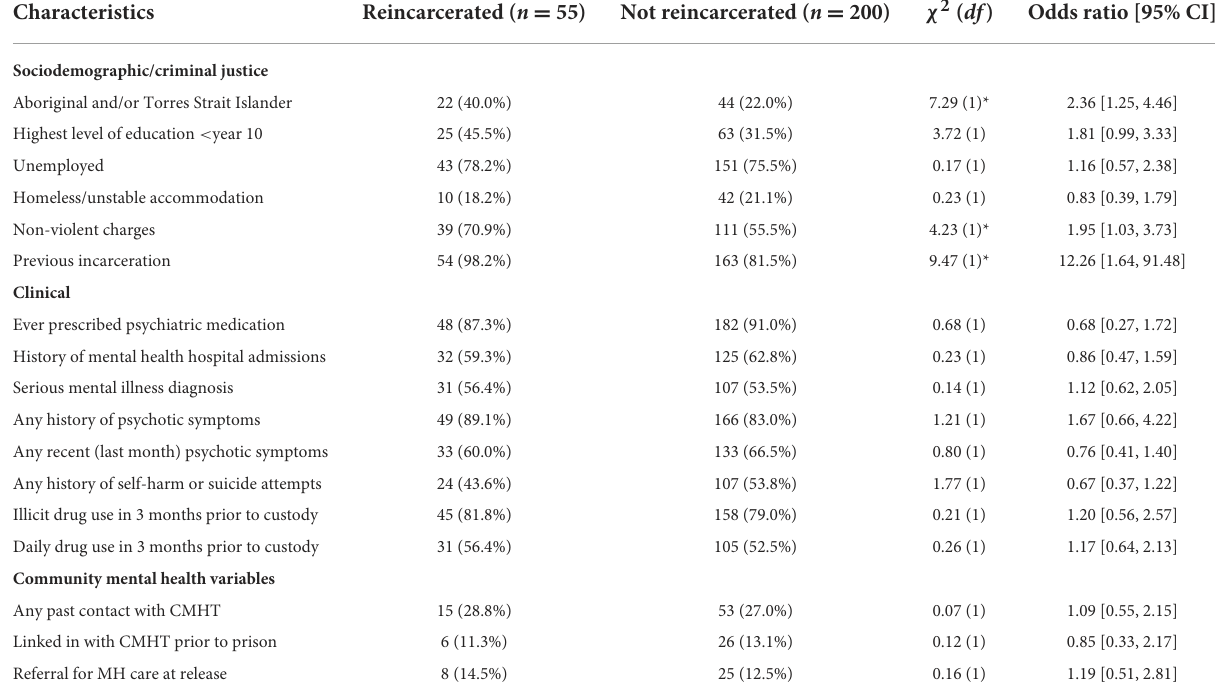
TABLE 5 Comparison of baseline sociodemographic, criminal justice and clinical characteristics of participants reincarcerated within 3 months of release, with those not reincarcerated.